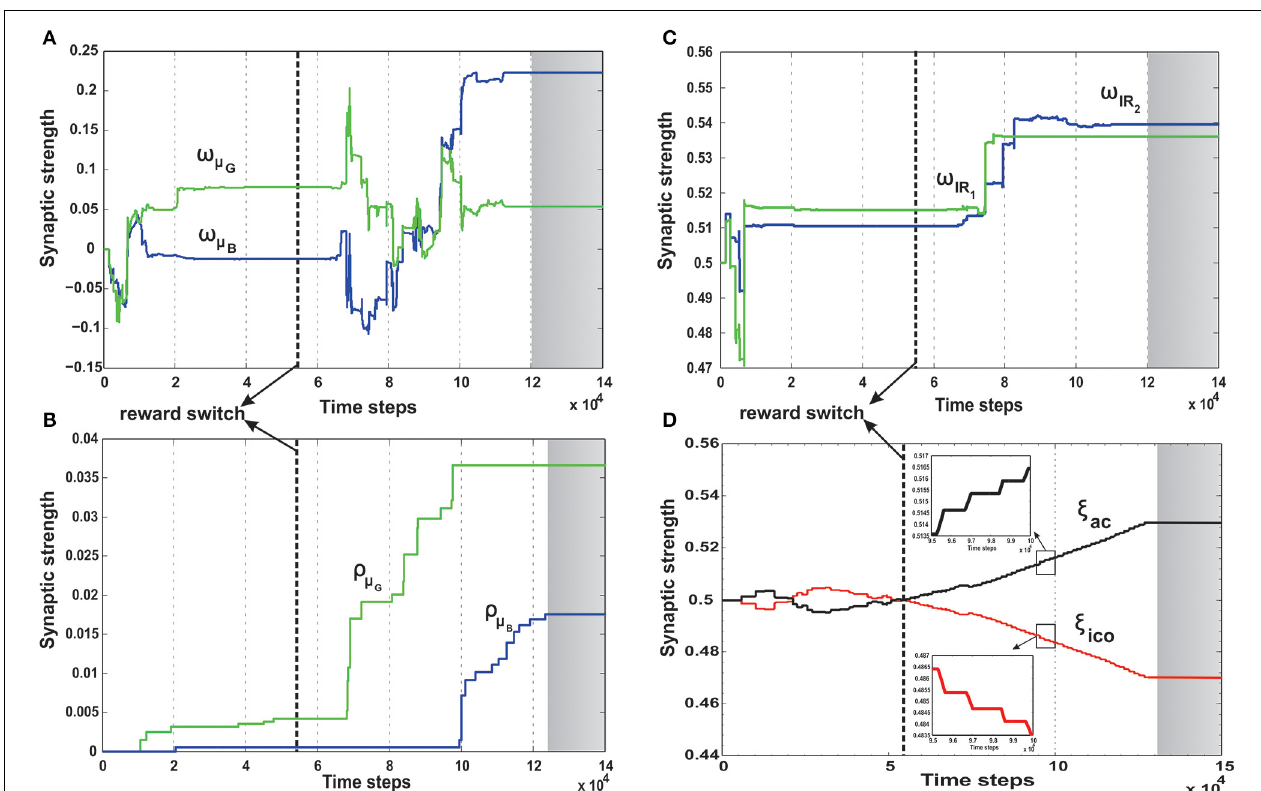
FIGURE 11 | Synaptic weight change curves for the dynamic foraging components. ξ ico —weight of the ICO network output (depicted in red), ξ ac —weight of the actor-critic RL network output (depicted in black). Here task. (A) Change in the synaptic weights for actor-critic RL learner. Here corresponds to the input weights of the orientation sensor toward the ICO weights converge initially for the first part of the task, however w μ G corresponds to the the green food source (spherical object) and w μ fail to re-adapt upon change of reward signals. This is counter balanced B input weights of the orientation sensor toward the blue. (B) Change in by the correct evolution of the actor weights. As a result although initially —the CS stimulus weight the synaptic weights of the ICO learner. ρ μ the combinatorial learner places higher weight for the ICO network, after G the CS stimulus weight for for the orientation sensor toward green, ρ μ task switch, due to change in reinforcements the actor-critic RL system B the orientation sensor toward blue. (C) Change in the weights of the receives higher weights and drives the actual behavior of the robot. The —left IR sensor weight, two infrared sensor inputs to the actor. w IR inlaid plots show a magnified view of the two synaptic weights between 1 —right IR sensor weights. Modulation of the IR sensor weights w IR 9 . 5 × 10 4 - 10 × 10 4 . The plots show that the weights do not change in 2 initially and during the periods 7 × 10 4 - 9 × 10 4 time steps can be a fixed continuous manner, but increase/decrease in a step like formation attributed to the high degree of exploration during this time, where in the corresponding to the specific points of reward activation ( Figure 10A ). In robot has considerable collisions with the boundary walls triggering these all the plots the gray shaded region mark the region of convergence for sensors (see Figure 7C ). (D) Learning curve of the RMHP combined the respective synaptic weights, and the thick dashed line (black) marks learning mechanism showing the change in the weights of the individual the point of reward switch. (see text for more